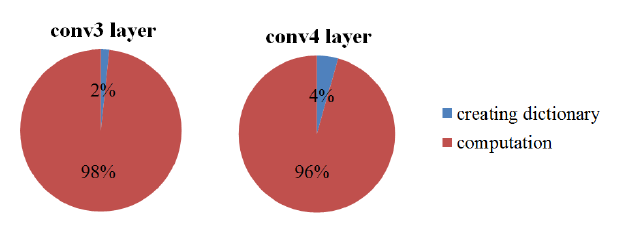
Figure 11. Time ratio of creating dictionary and multiplication.